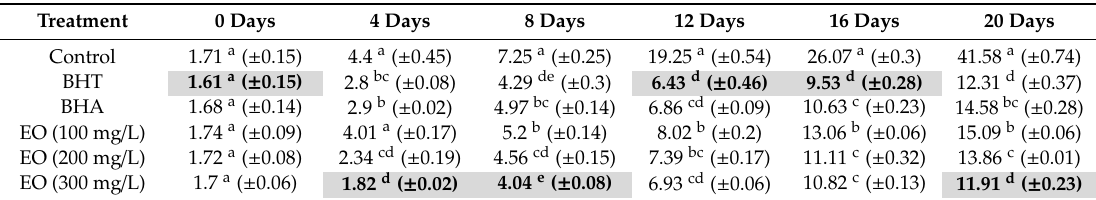
Table 2. Inhibitory e ff ect of the P. sylvestris seeds essential oil on the primary oxidation of sunflower oil measured by peroxide value method (meq of oxygen kg − 1